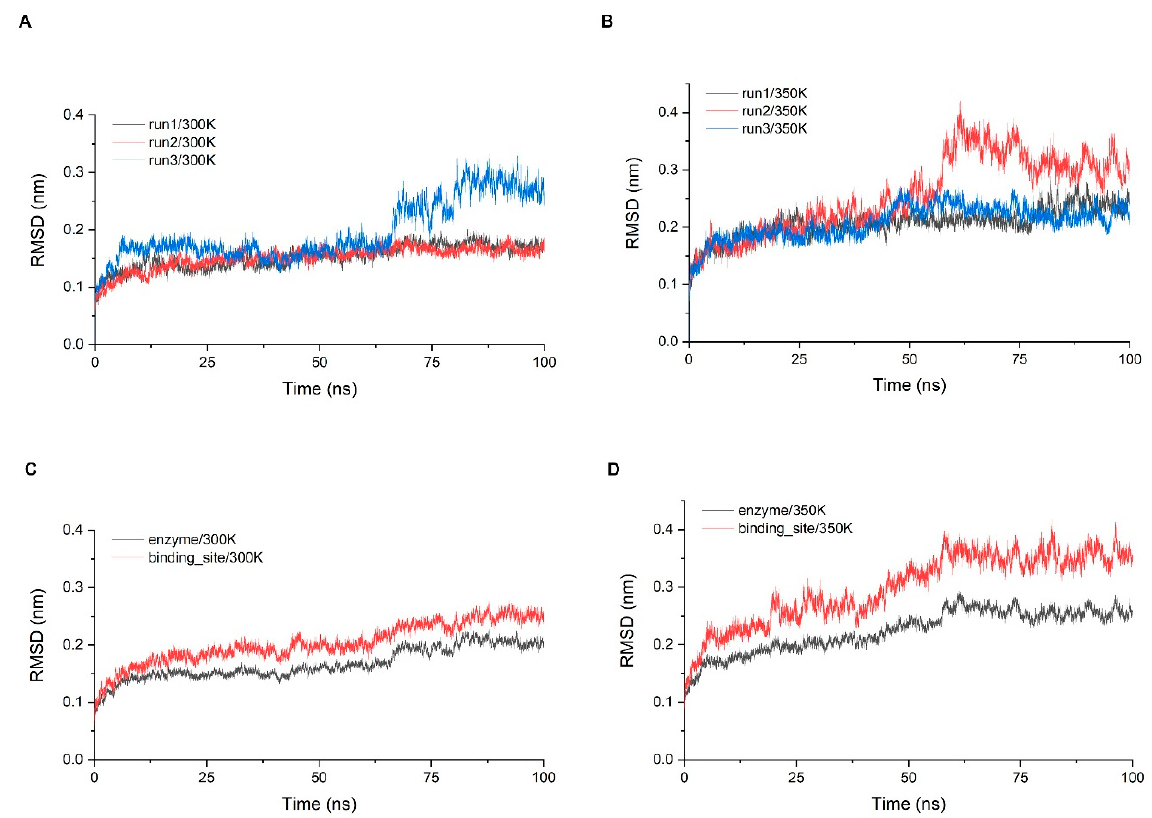
Figure 4. ( A , B ) The RMSD of the three simulations at 300 K and 350 K; ( C , D ) show the comparisons of the RMSD average values between the whole structure and binding site at each temperature.